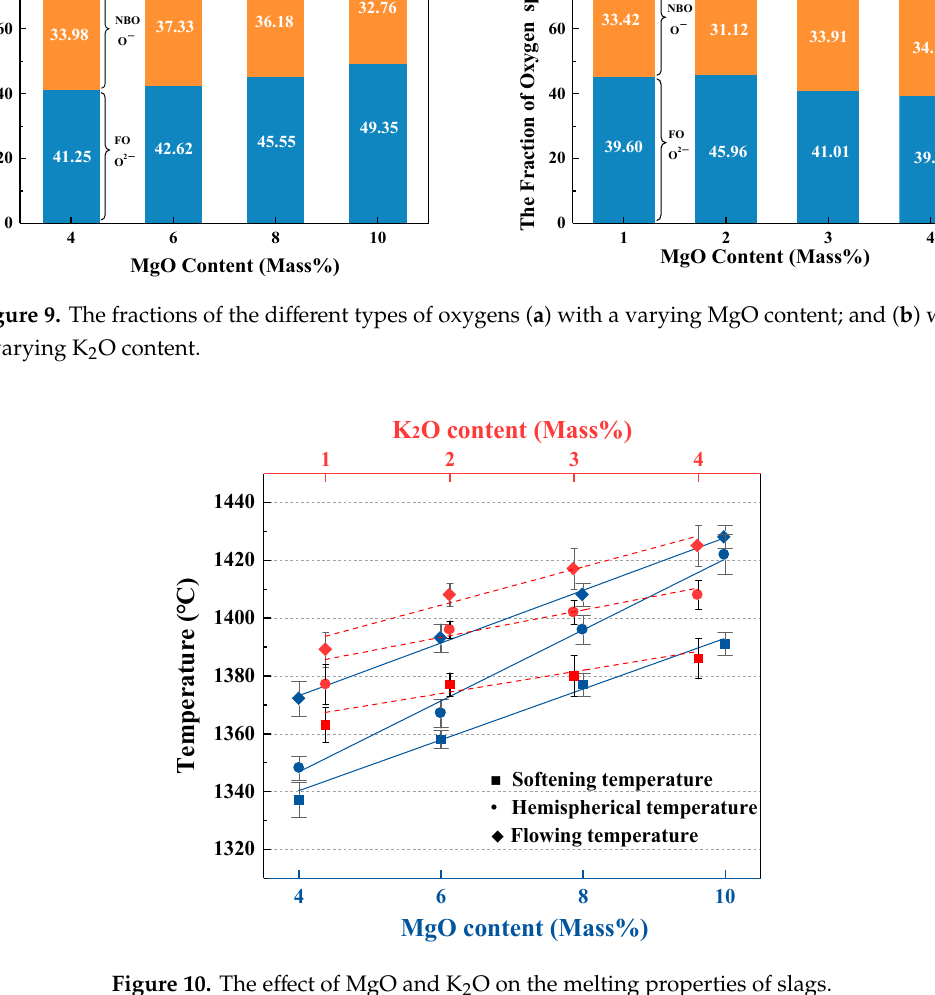
Figure 10. The effect of MgO and K 2 O on the melting properties of slags. Figure 10. The e ff ect of MgO and K 2 O on the melting properties of